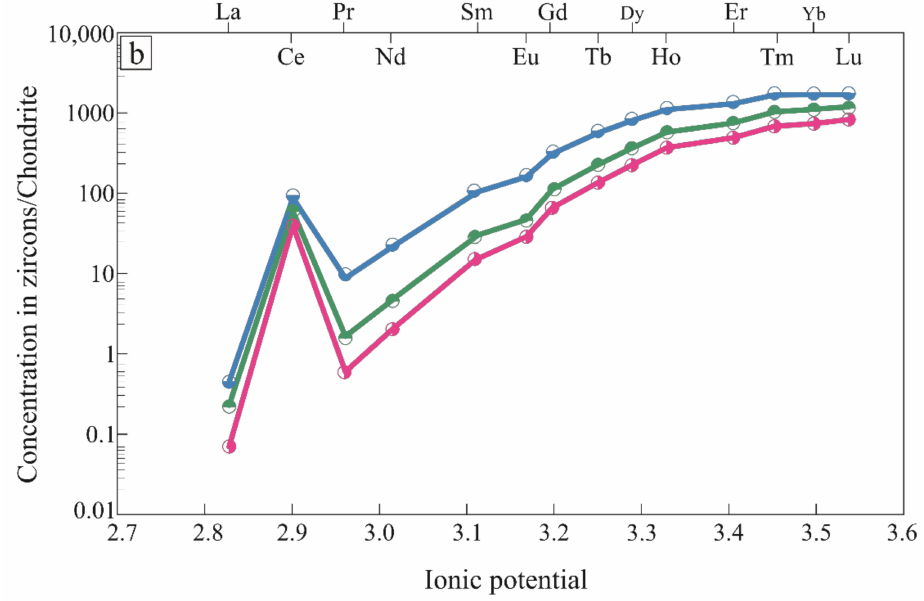
Figure 8. ( a ) Major Zr and trace element concentrations in zircon, normalised to chondrite [23], plotted as a function of ionic potential. ( b ) Zircon REE concentrations, normalised to chondrite [23], were plotted as a function of ionic